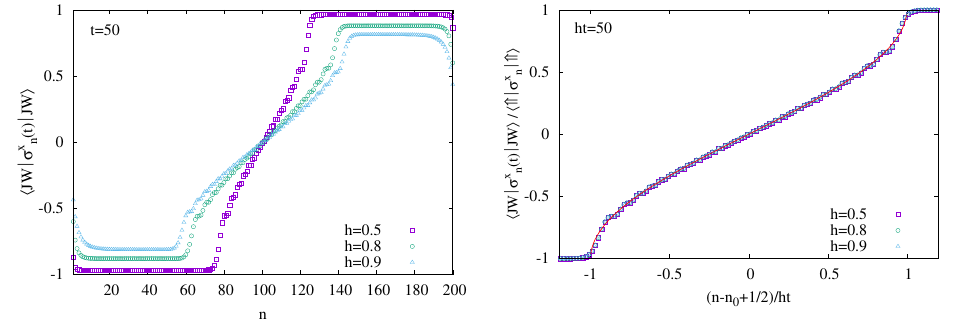
Figure 1: Magnetization profiles for a JW excitation in a chain of length N = 200. Left: at time t = 50 and for various values of h . Right: normalized profiles with a rescaled horizontal axis, for ht = 50 kept fixed. The symbols for various h can not be distinguished due to the perfect data collapse. The solid line shows the semi-classical result, see Eqs. (26) and